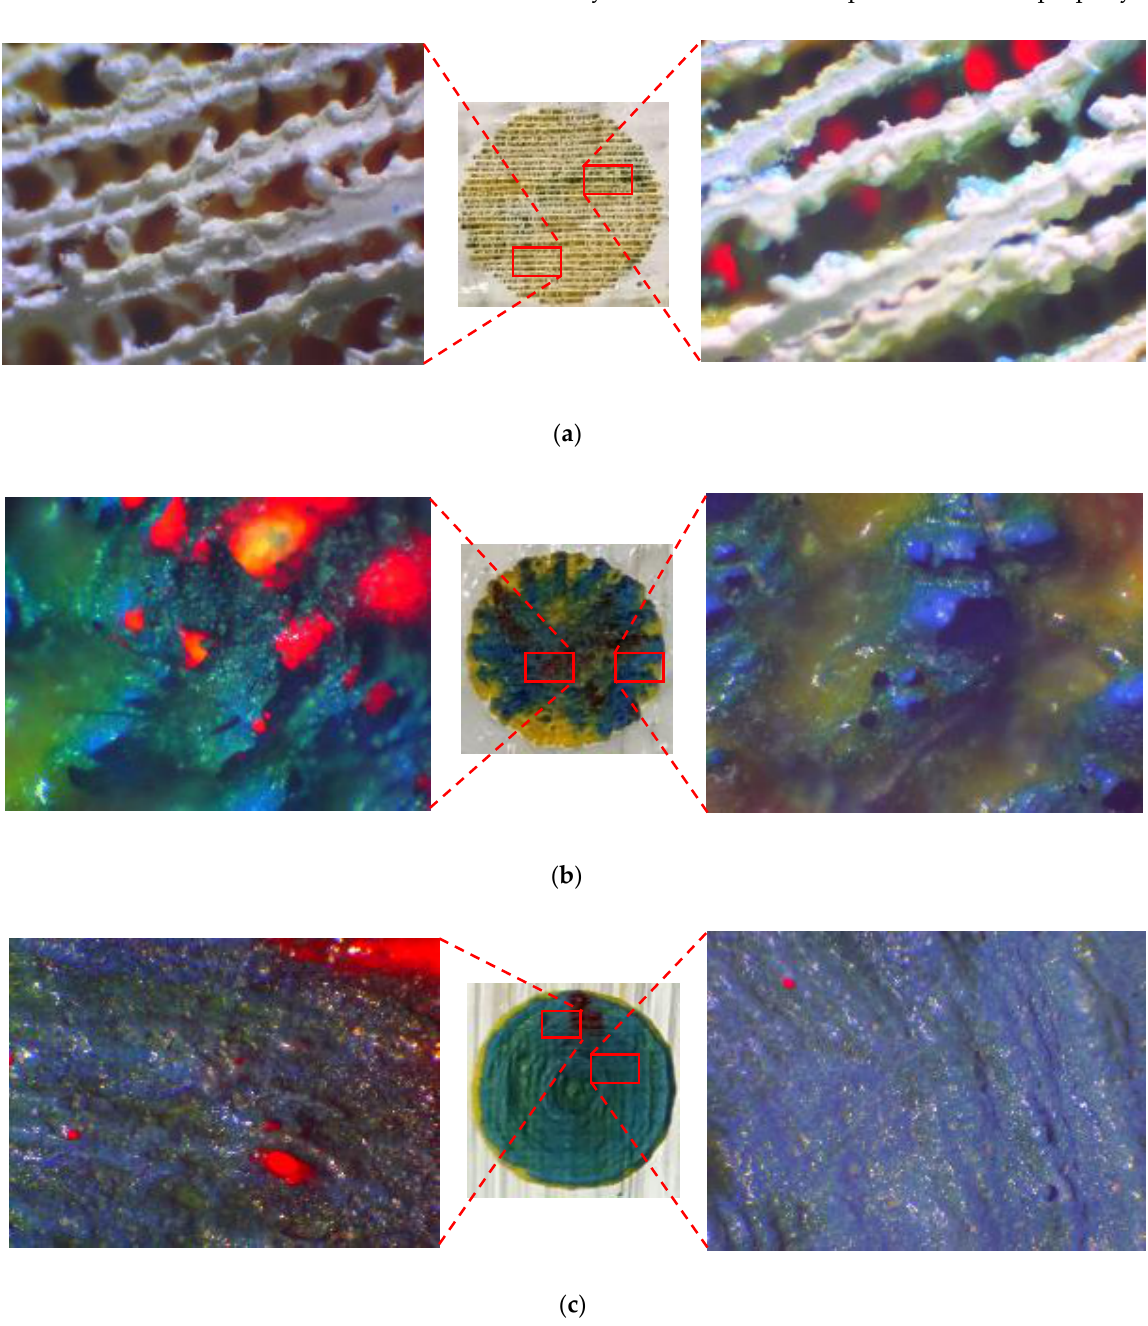
Figure 14. Micrographs of preliminary experiments on colored surface with different roughness (Ra) measurements: ( a ) Ra = 10.13, ( b ) Ra = 8.6, and ( c ) Ra = 5.95.